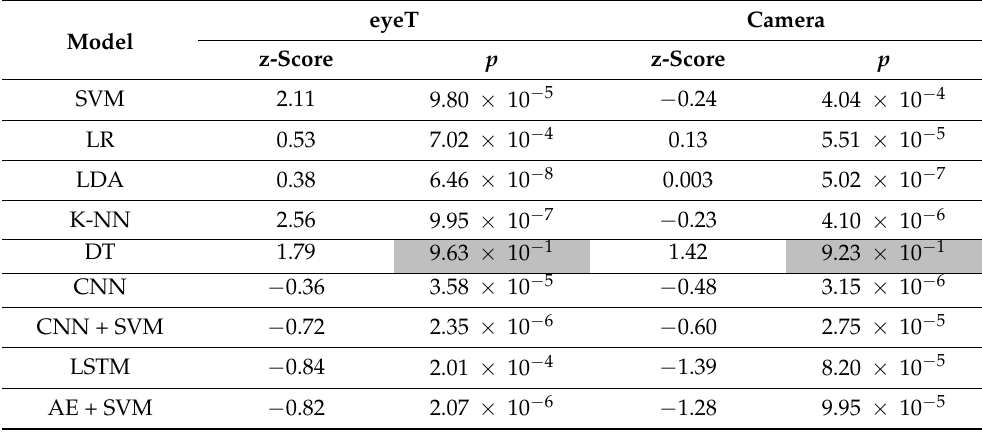
Table 6. Summary of the wilcoxon